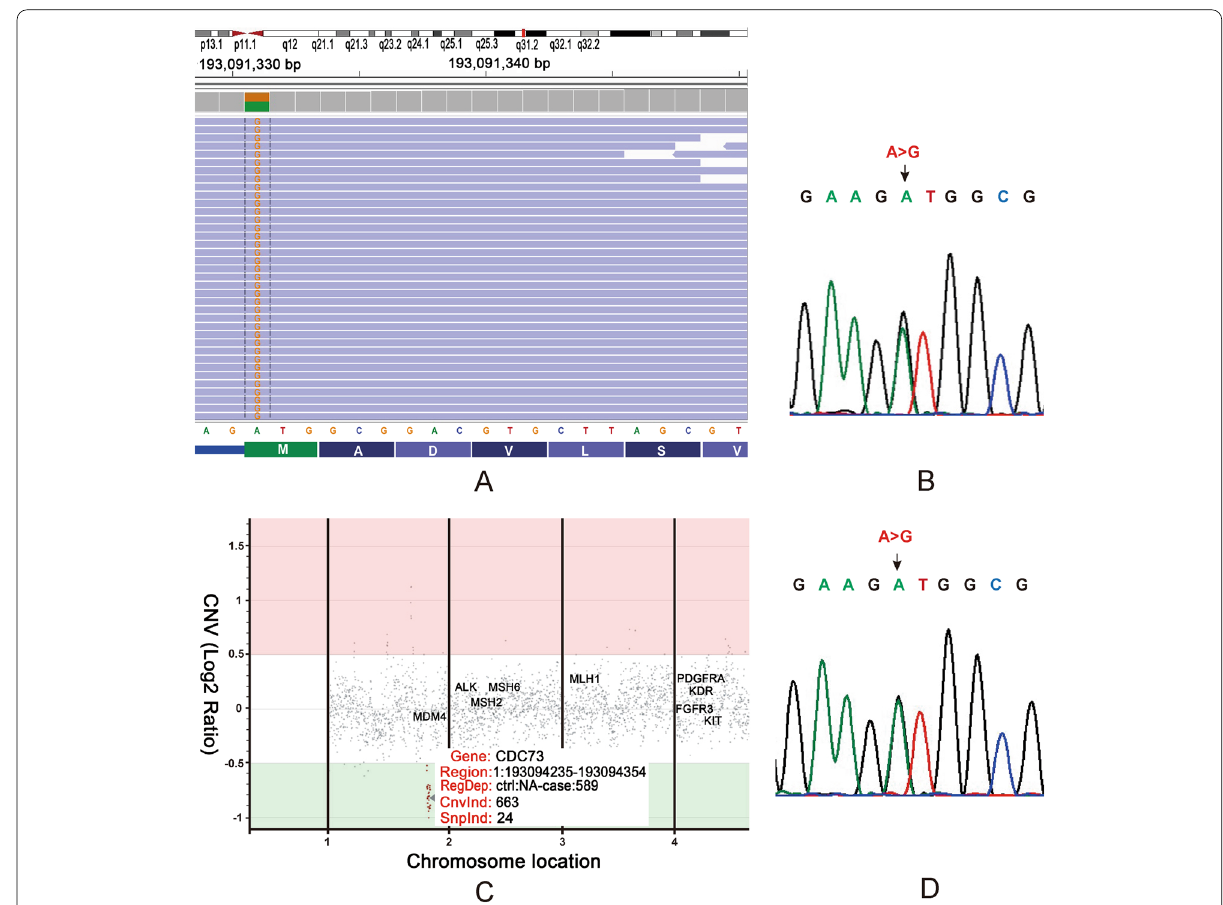
Fig. 4 Gene testing of blood and jaw tumor DNA samples. A NGS testing of pan-tumor related 1021 genes demonstrating CDC73 germline point mutation (c.1A > G, p.Met1Val). B Chromatographs of CDC73 sequencing verify the heterozygous germline A to G change in the blood DNA from the patient III:1. C NGS visual image of the proband’s jaw OFs sample showing a heterozygous deletion of a whole region of CDC73 with CNV ratio